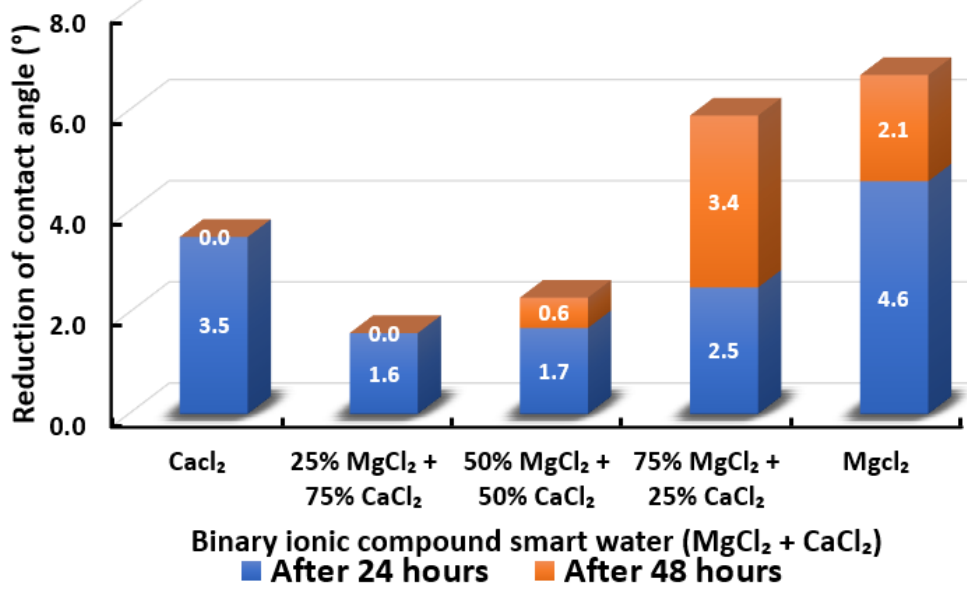
Figure 18. Contact angle reduction results for binary ionic compounds smart water (SW) solutions MgCl 2 + CaCl 2 (3500